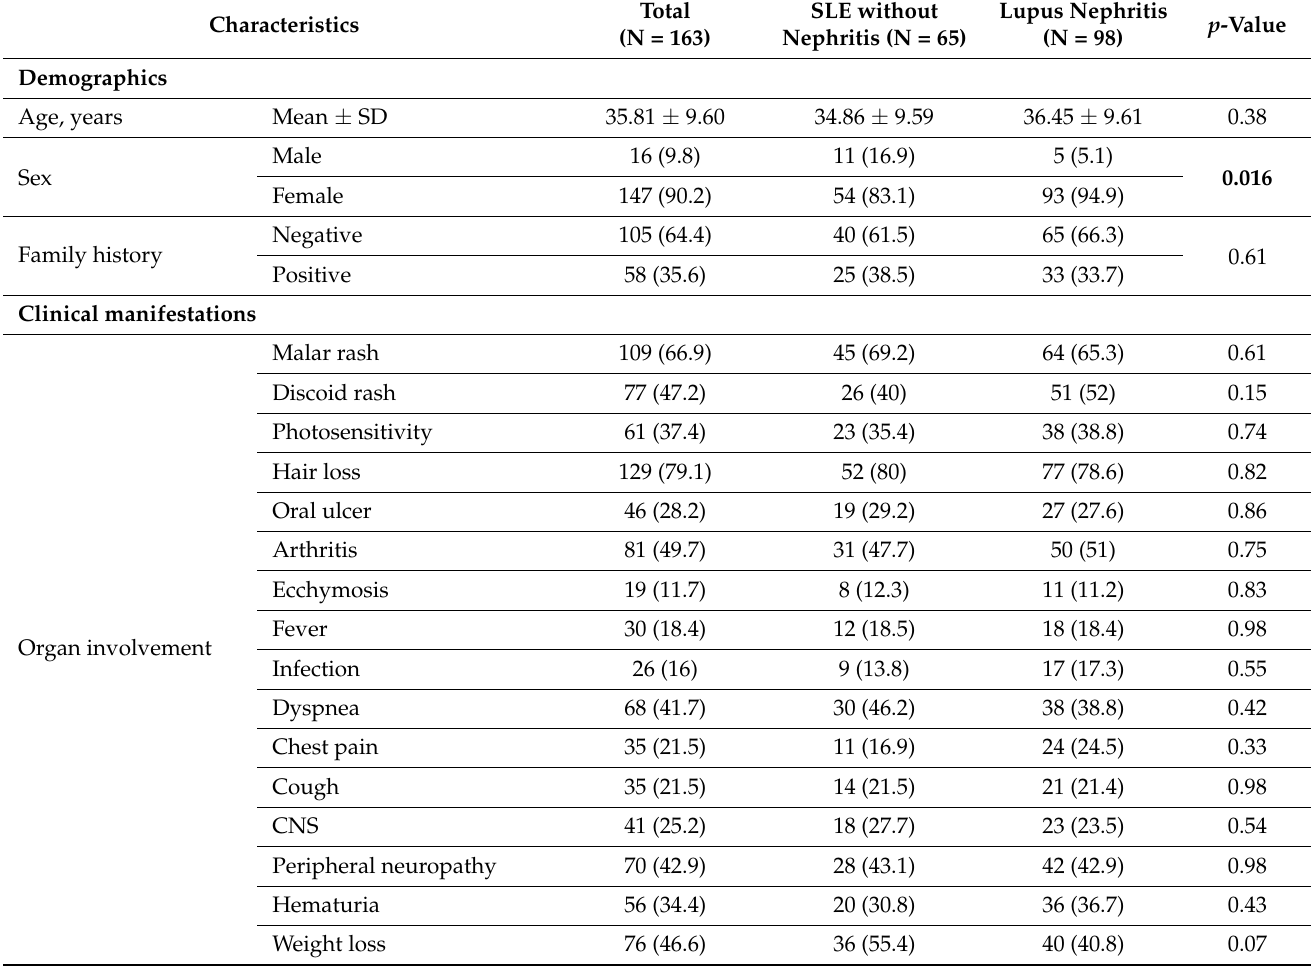
Table 1. Characteristics of SLE patients with/without lupus